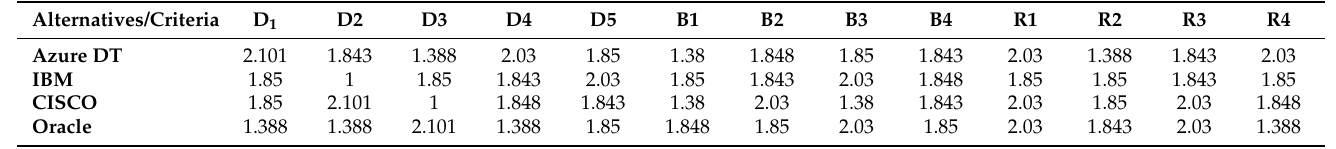
Table 7. The aggregated decision-maker judgments for DT alternatives.